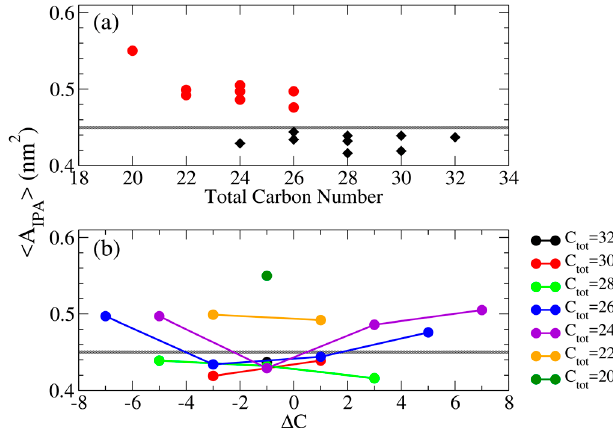
Figure 4. Averaged molecular area <A IPA > as function of ( a ) total alkyl carbon number (top panel) in which bilayers in S and Ld phases are colored in black diamonds and red dots, respectively, and as function of ( b ) Δ C (bottom panel) in which each line represents systems with equal total alkyl carbon numbers. The gray lines represent the threshold value of A IPA = 0.45 nm 2 to distinguish the Ld and S phases.